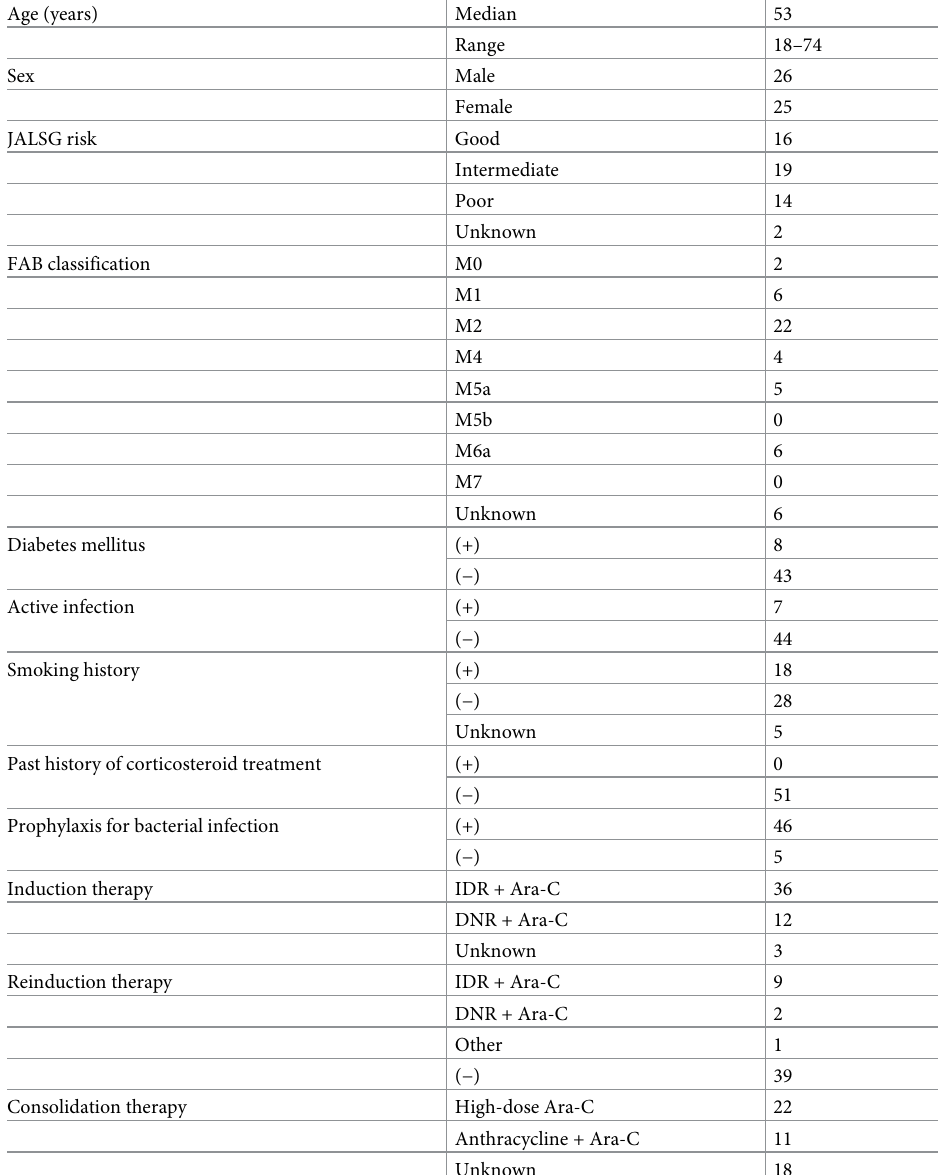
Table 1. Patient